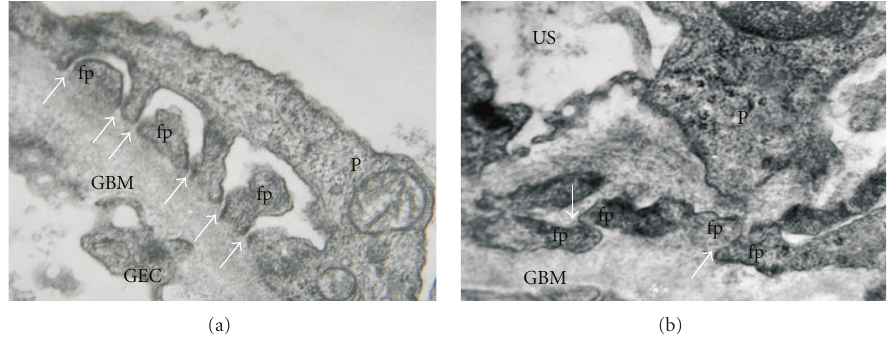
Figure 2: Glomerular filtration barrier in normal and pathological conditions. (a) A cross-section of a normal human glomerular capillary. Arrows indicate the foot processes with interconnecting ultrathin slit diaphragms. (b) Significant changes in the glomerular filtration barrier in a patient with heavy proteinuria due to a primary glomerulopathy. Note the foot process e ff acement with alteration in slit diaphragm (arrows), which results in a disarrangement of the functional filter structure. Abbreviations: fp: foot process; GBM: glomerular basement membrane; P: podocyte; GEC: glomerular endotelial cell; US: urinary space. (Transmission electron microscopy. Uranyl acetate-lead citrate original magnification ×